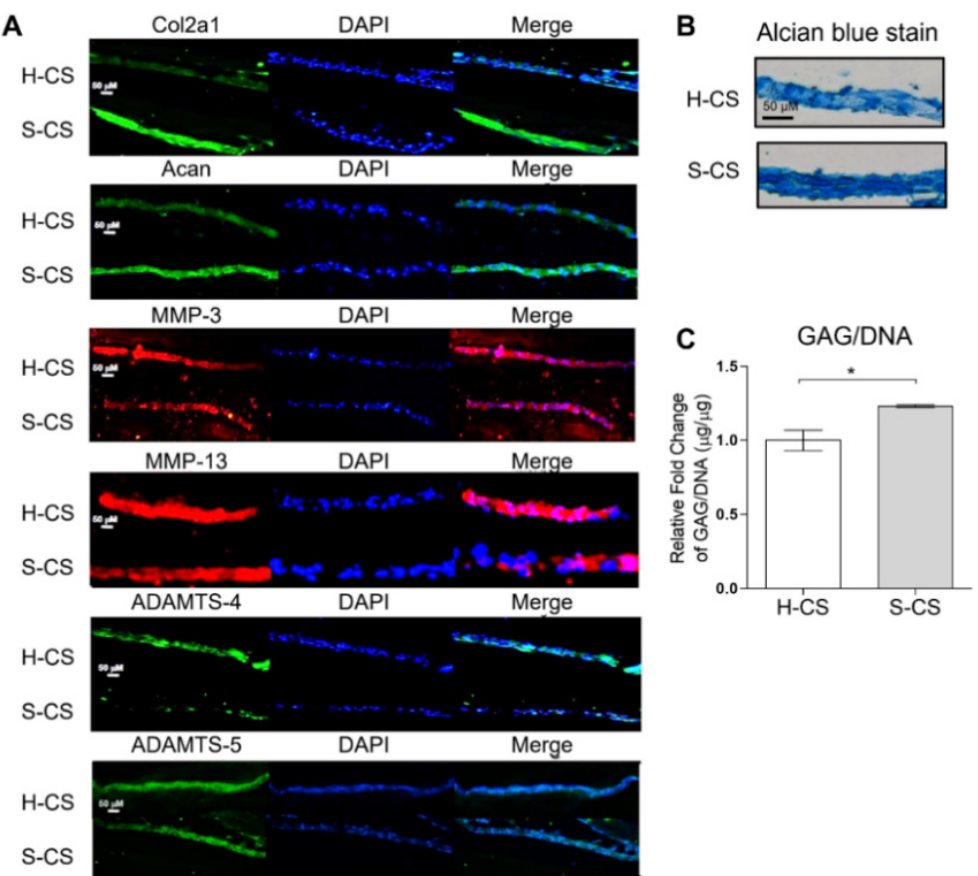
Figure 5. Microscopic images of histological section. Image of heterogeneous chondrocyte sheets (H-CS) and stratified chondrocyte sheets (S-CS). ( A ) Immunofluorescence staining for Col2a1, Acan, MMP-3, MMP-13, ADAMTS-4, and ADAMTS-5. (Scale bar = 50 µm) ( B ) Alcian blue stain of H-CS and S-CS. ( C ) Total glycosaminoglycan (GAG) content of H-CS and S-CS. (*, p < 0.05).